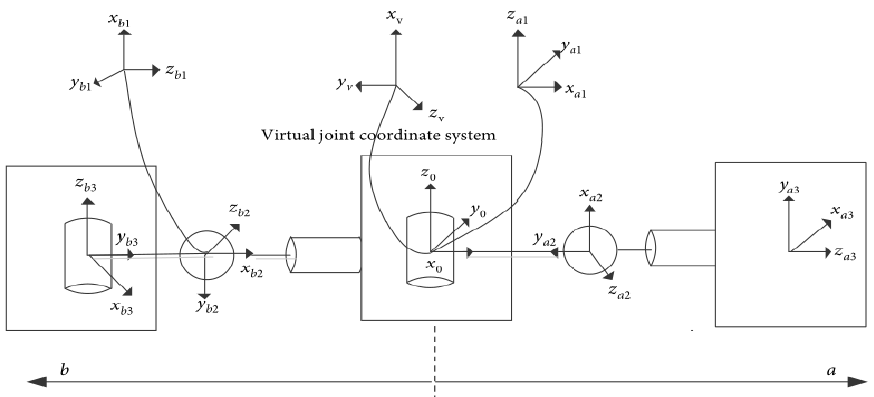
Figure 7. Virtual coordinate system of SMRS.